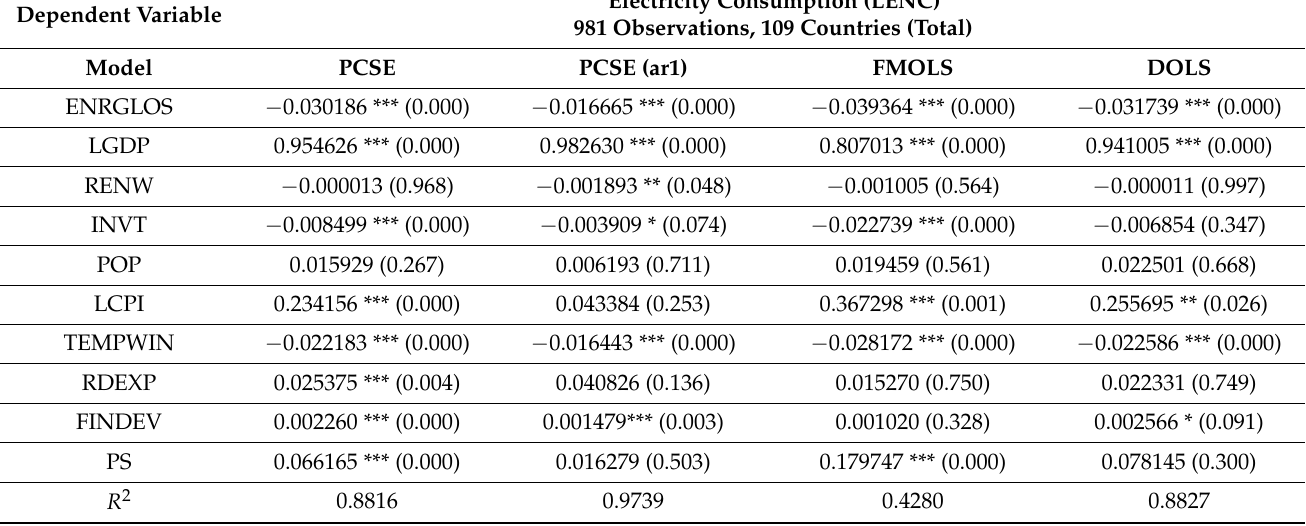
Table 5. Electricity consumption and its determinants: results with the PCSE, FMOLS, and DOLS estimation